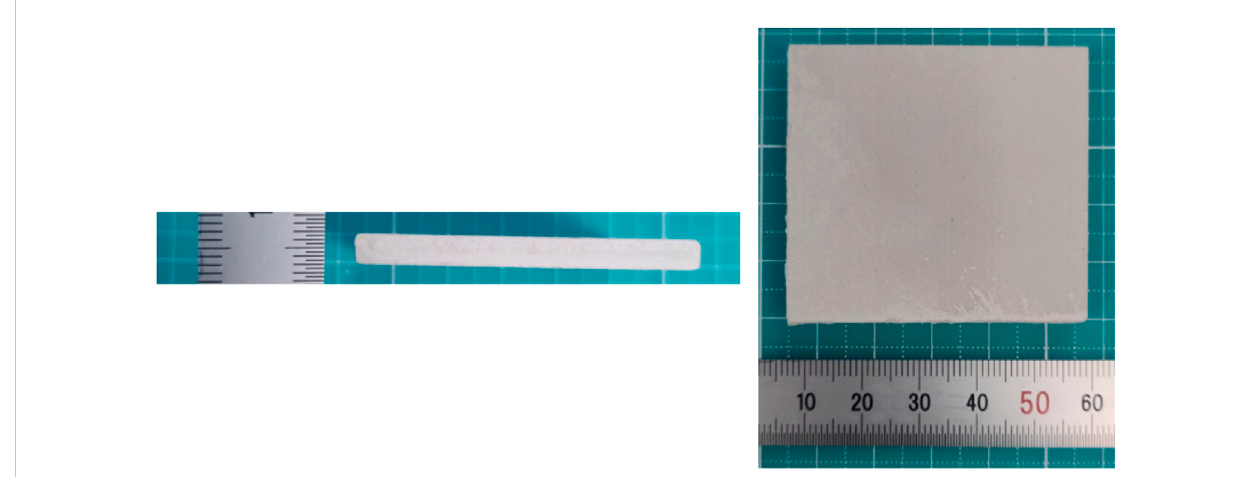
FIGURE 6 An overview of the phantom in the TCD experiment.